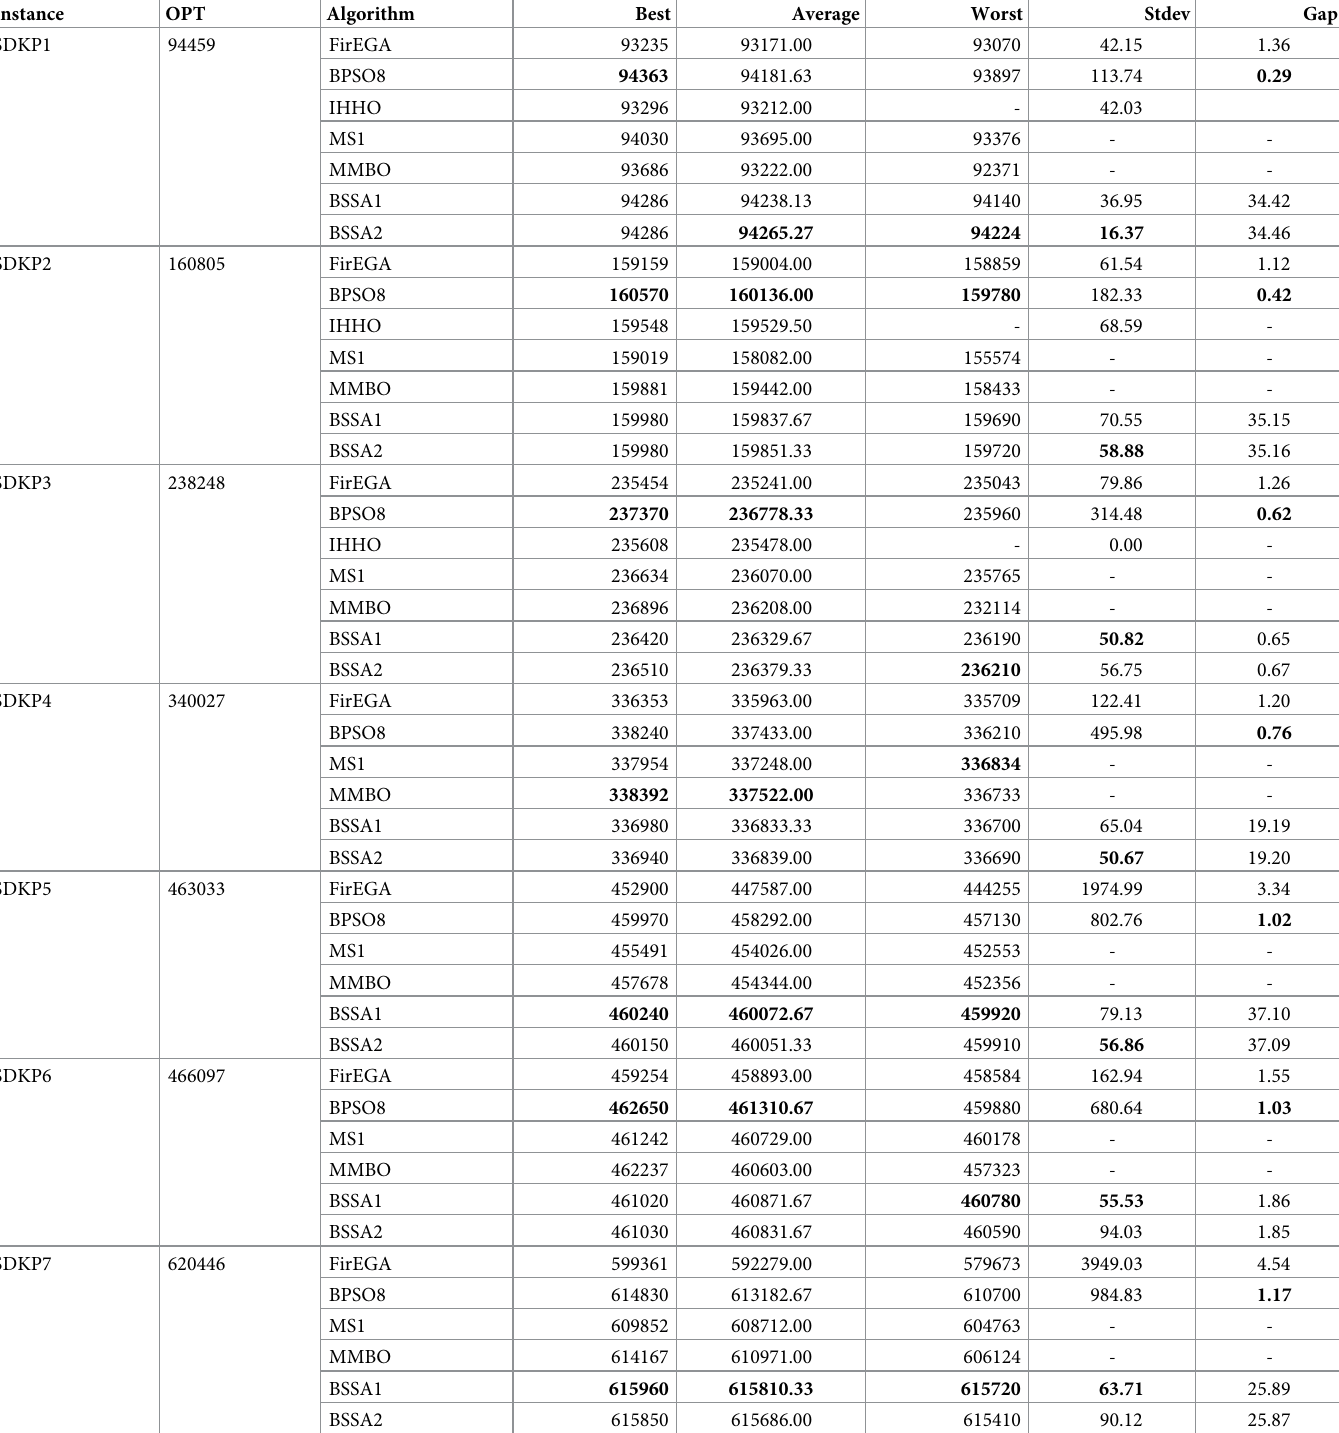
Table 6. Test results with strongly correlated